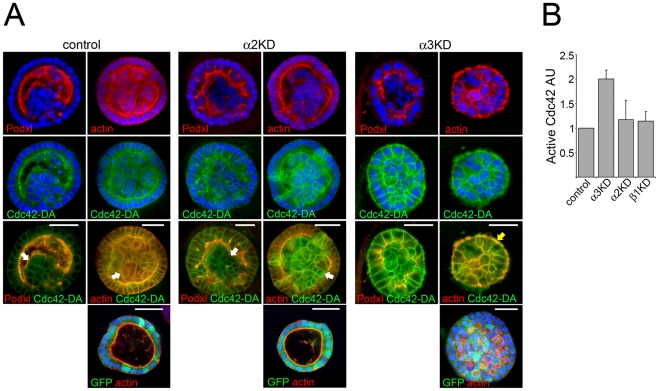
α3β1-integrin modulates the function of Cdc42.A) Control, Itgα2- and Itgα3-KD MDCK cells were transduced with GFP- or Cdc42Q61L-GFP expressing retroviruses. Transduced cells were seeded into 3D BME-gels and grown for 7 days to allow formation of cysts. Cysts were fixed and stained for actin (red, right panels) or podocalyxin (red, left panels). Active Cdc42-GFP is shown in green. Nuclei were visualized using DAPI (blue). B) Control, Itgα3-, Itgα2- and Itgβ1-KD MDCK cells were seeded onto BME-gel and grown to confluency. Cells were lysed and the amount of GTP-loaded Cdc42 in the lysates was measured using G-LISA™ assay. The data is shown as mean +SD and is representative of 2 independent experiments. Sizebars are 30 µm.